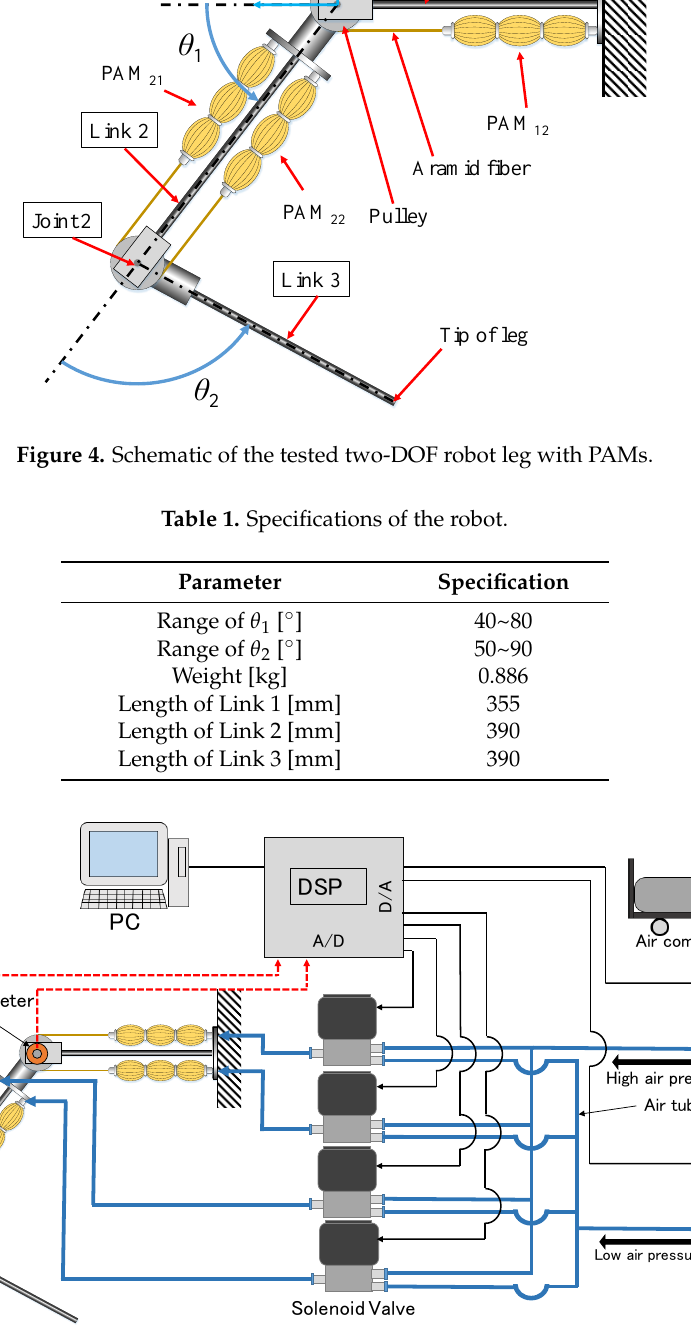
Figure 5. The control system of the robot.